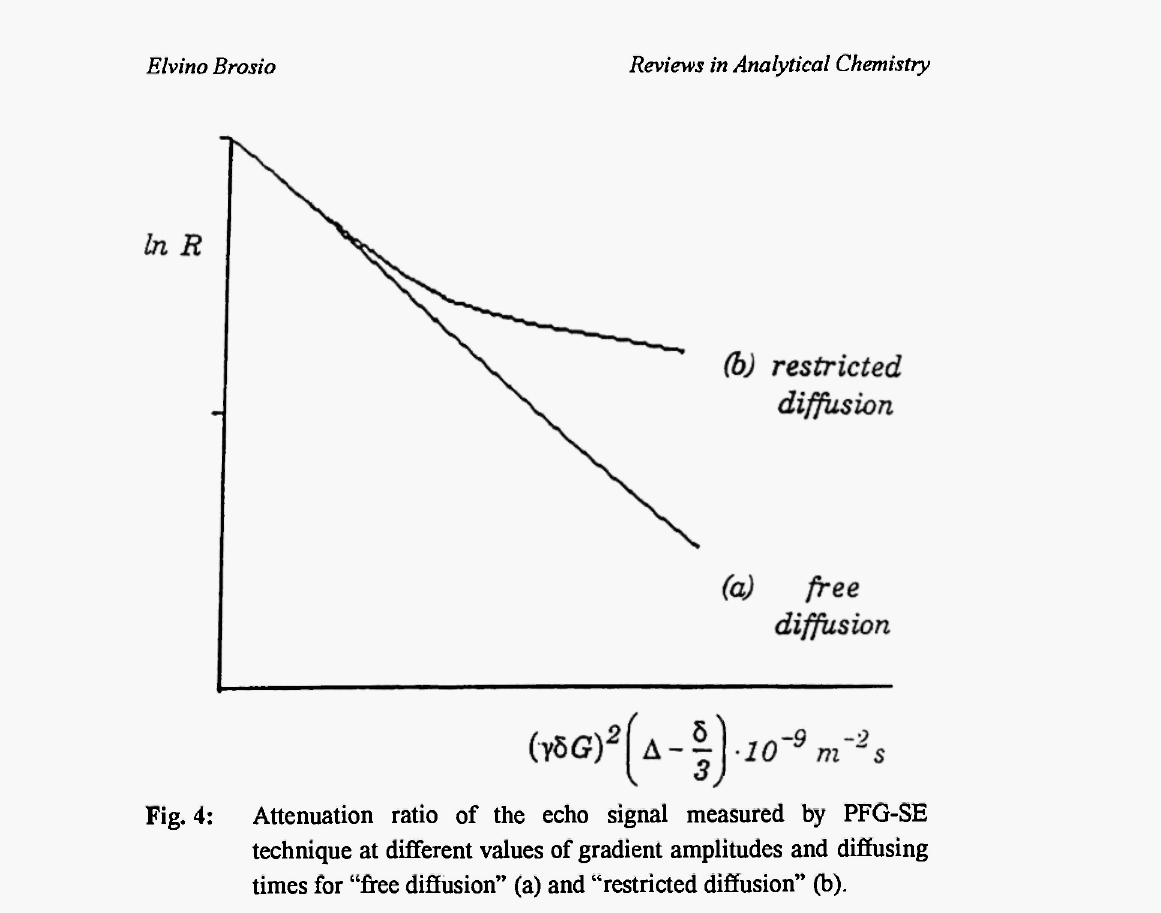
Fig. 4: Attenuation ratio of the echo signal measured by PFG-SE technique at different values of gradient amplitudes and diffusing times for "free diffusion" (a) and "restricted diffusion"